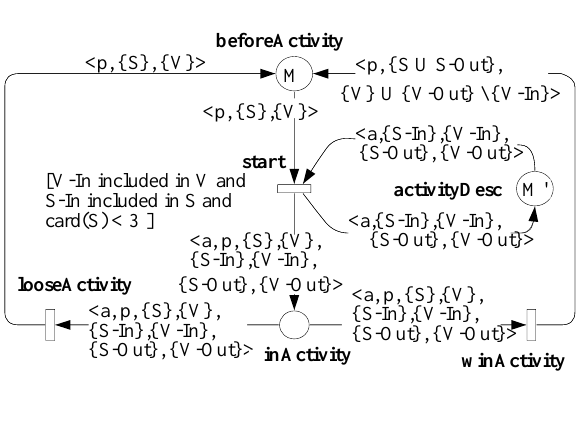
Figure 4. Part of the Nuxil game